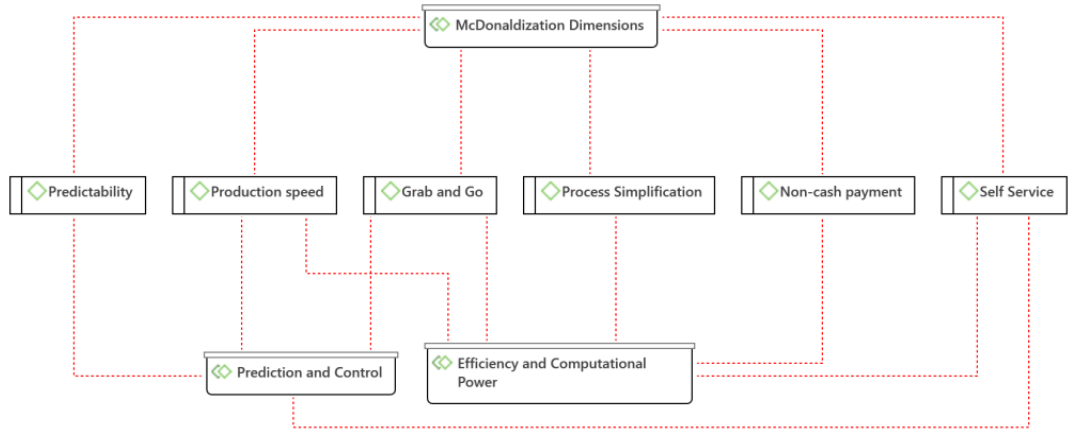
Fig. 1 Dimension Mcdonaldization in reality Coffee shop Janji